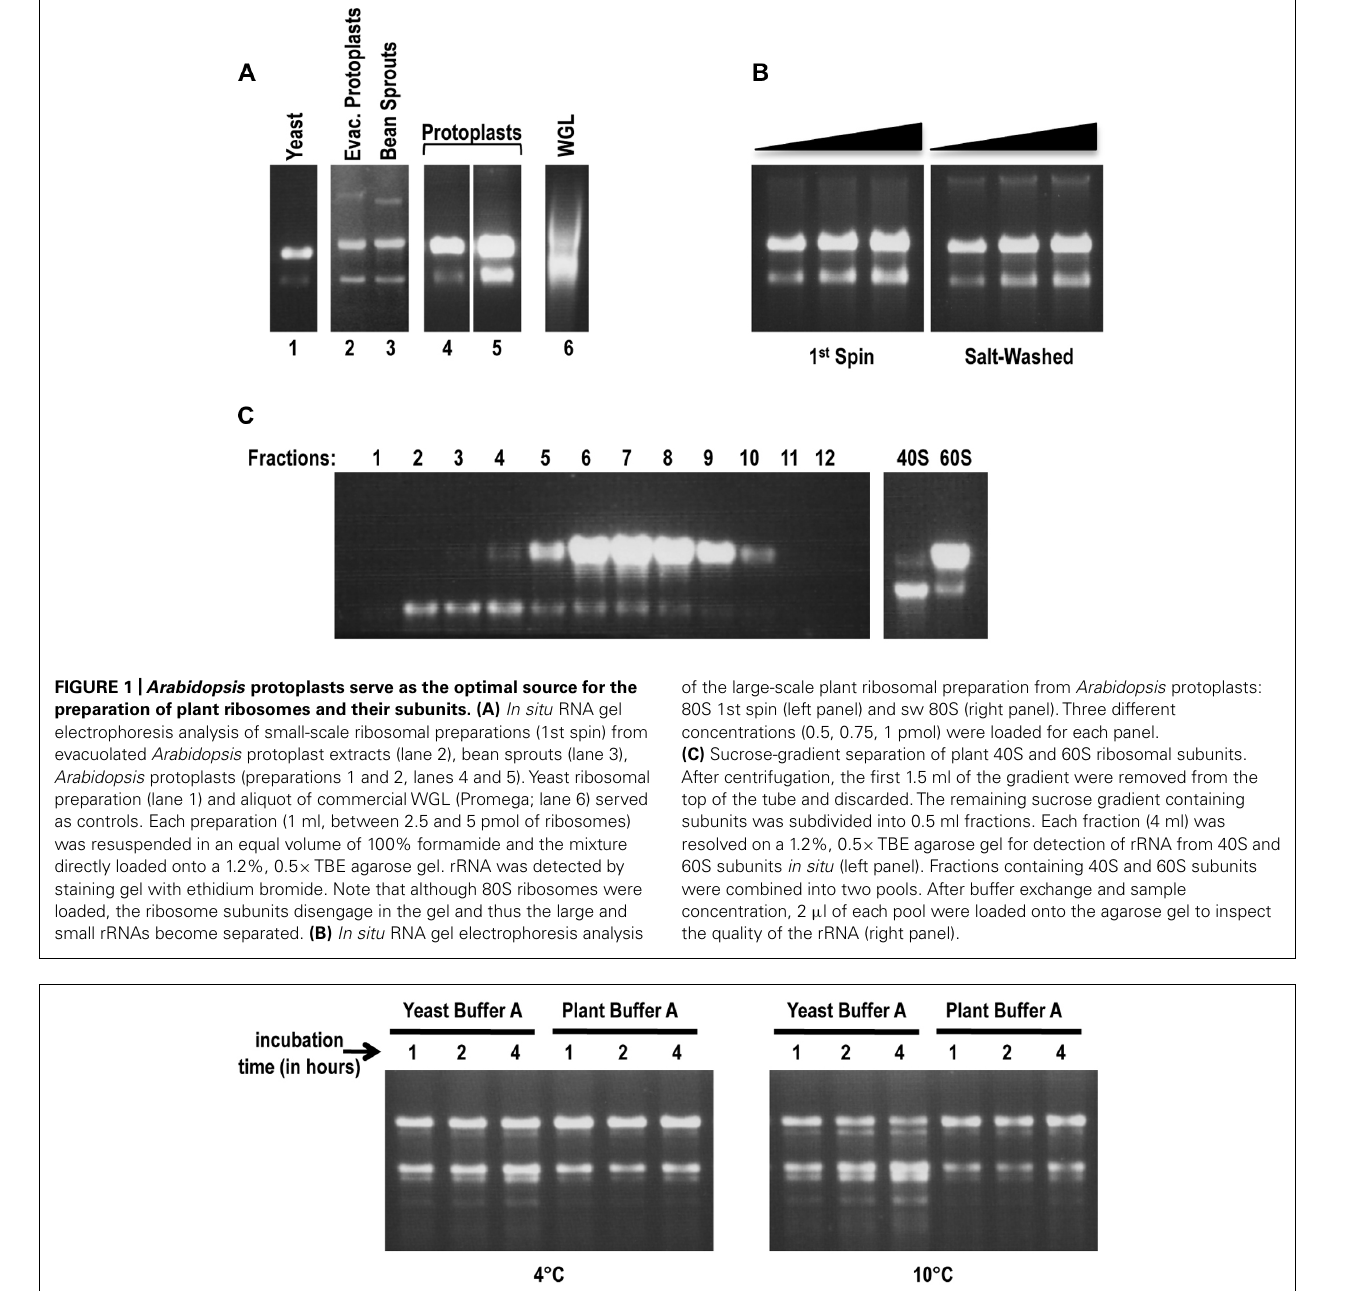
FIGURE 2 | RNA stability assays. Frozen protoplast pellets were re-suspended in either yeast buffer A or plant buffer A. Suspensions were incubated at either 4 ◦ C (left panel) or 10 ◦ C (right panel). Aliquots were taken at 1, 2, and 4 h time points to extract rRNA. RNA (1 μ g) was inspected for integrity on 1.2%, 0.5 × TBE agarose